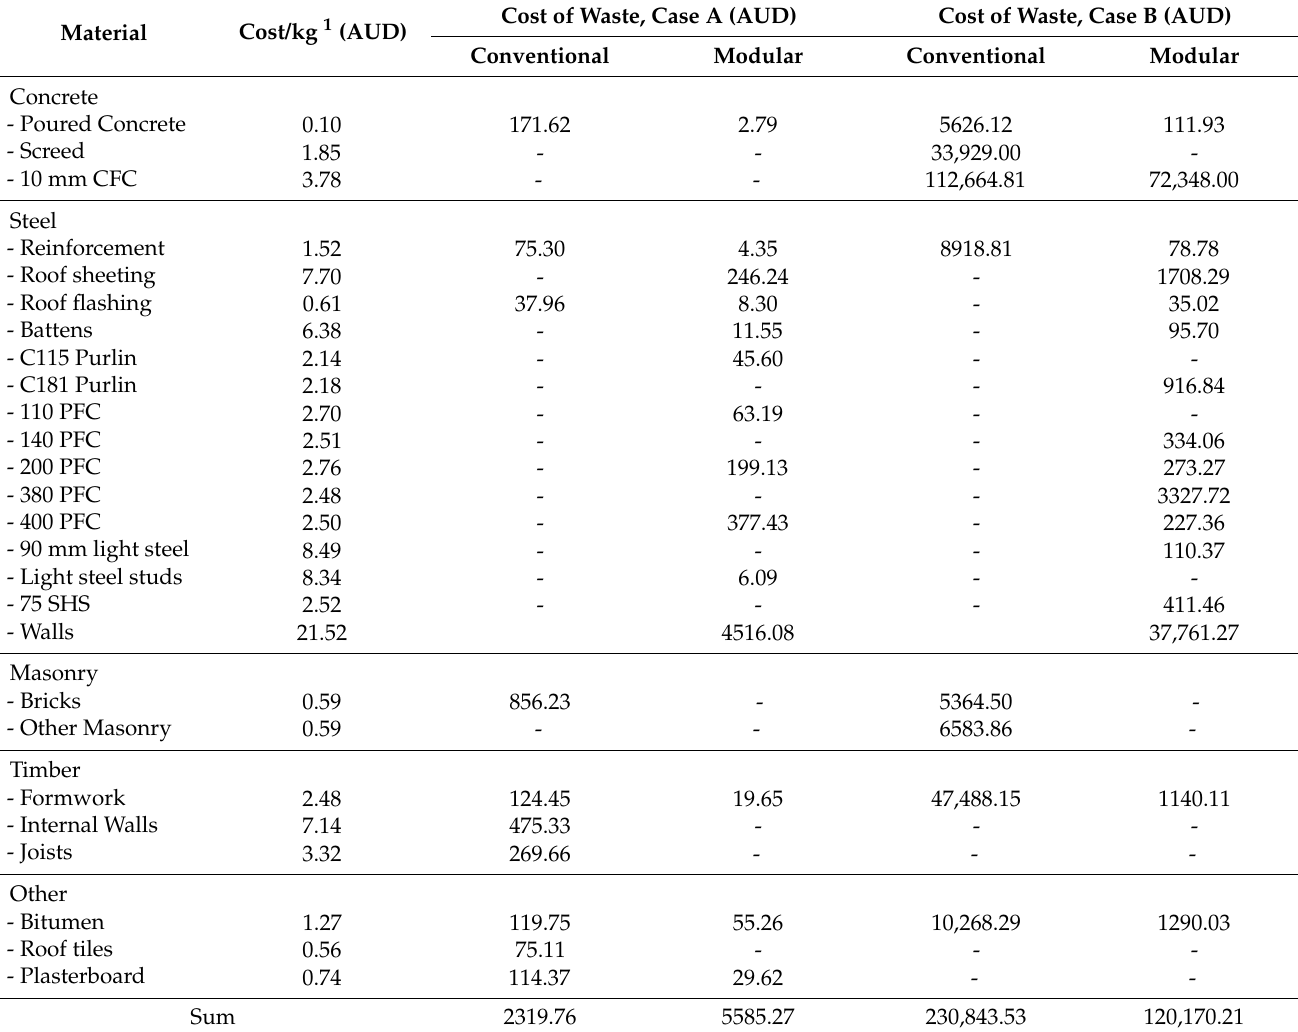
Table 11. Cost of waste for case studies and construction